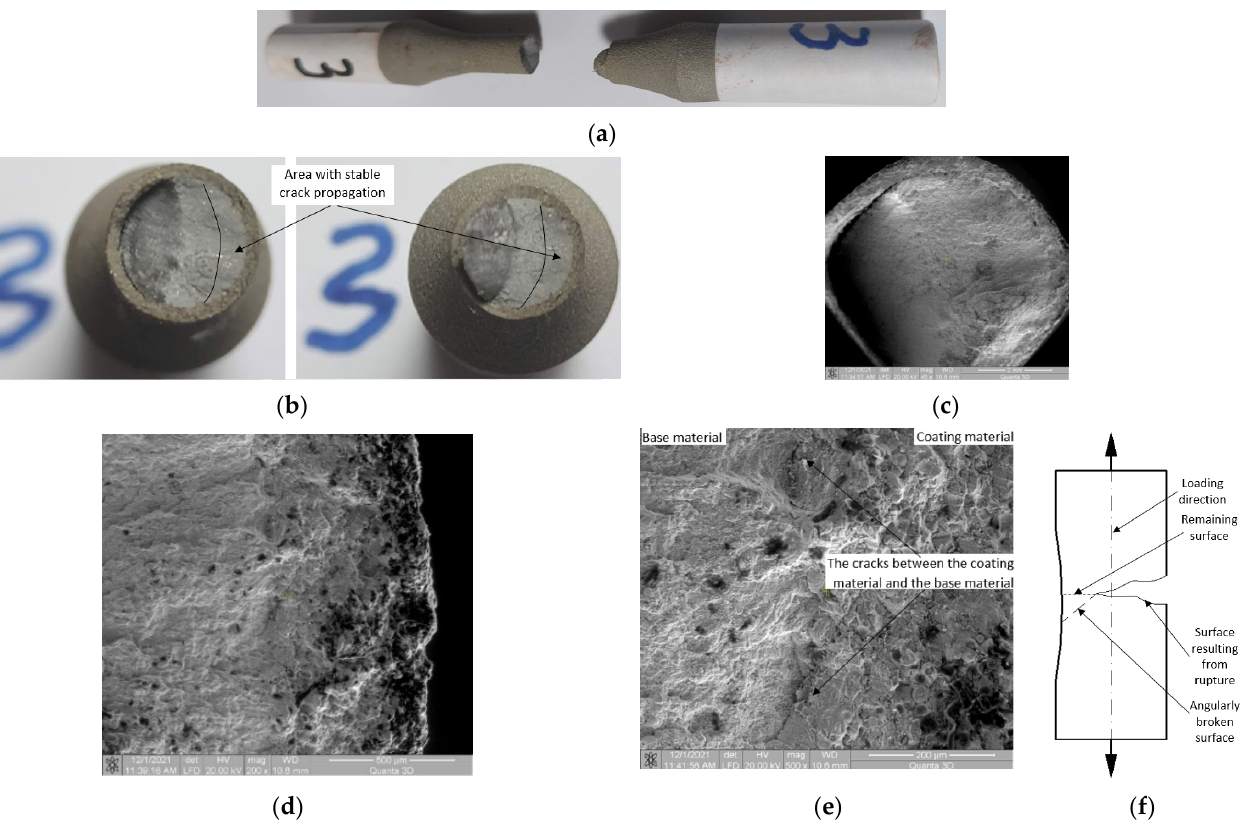
Figure 11. Macroscopic and microscopic appearance of broken surfaces for Sample 3, σ max = 530 MPa, N = 34,660 cycles. ( a ) Sample 3 broken by fatigue. ( b ) Fracture surfaces. ( c ) SEM image of the surface at 45× magnification. SEM image of the area where the crack initiated with ( d ) 200× and ( e ) 500× magnification. ( f ) The remaining area before total failure.